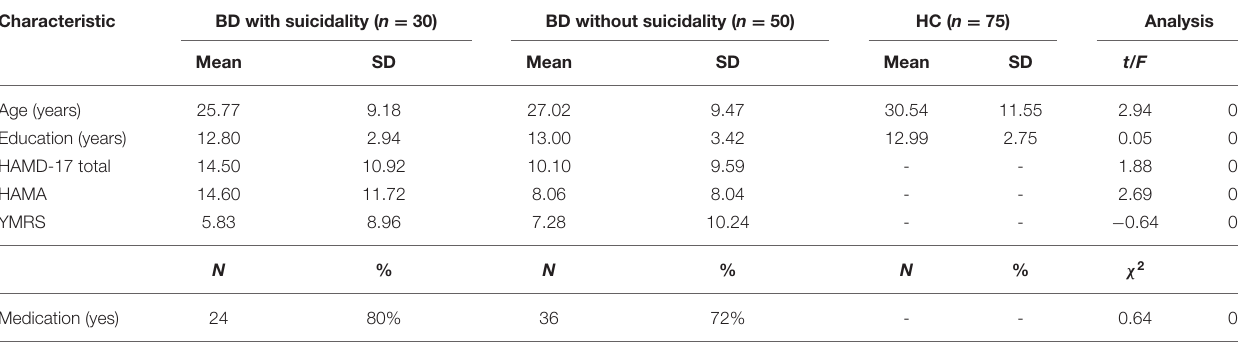
TABLE 1 | Clinical and demographic characteristic of all subjects. Characteristic BD with suicidality ( n = 30)